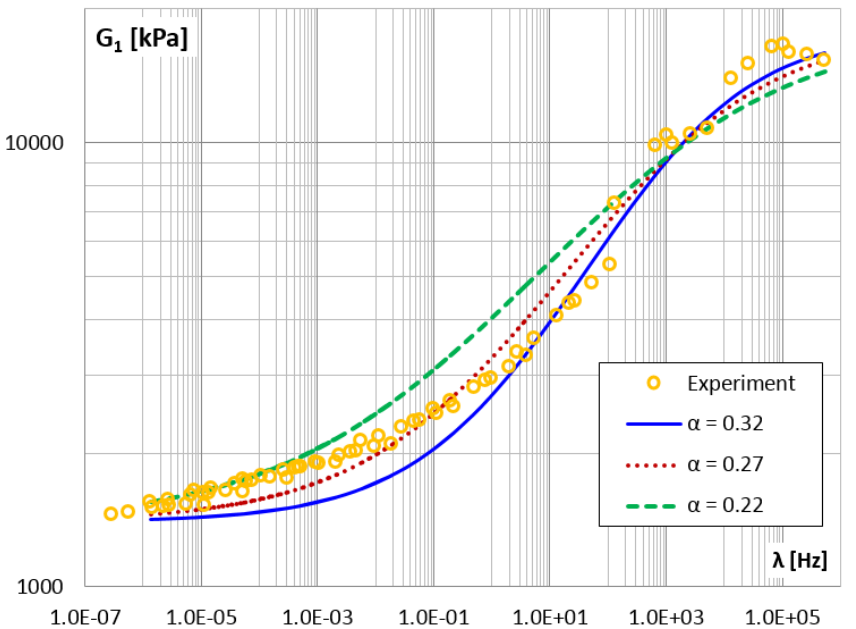
Figure 26. The shear storage modulus G 1 vs. frequency for different values of parameter α .